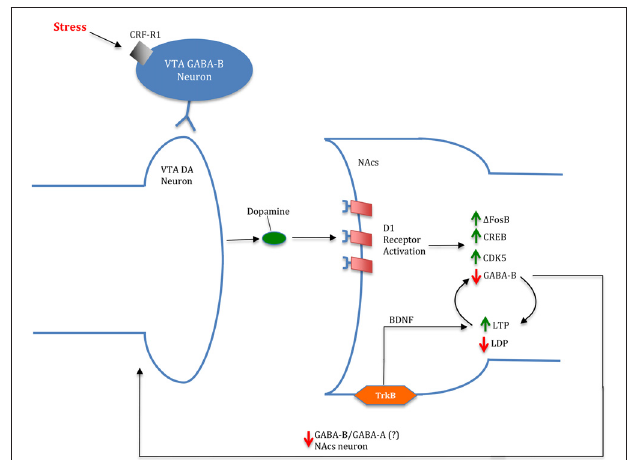
FIGURE 3 | Image of a potential mechanism for stress- and cocaine-induced drug dependence via a feed-forward cycle in the NAcs. In the presence of stress, ventral tegmental area (VTA) DA release is upregulated resulting in increased D1 receptor activation. Cortisol is implicated in increasing DA release through corticotropin-releasing factor acting at type 1 receptor (CRF-R1) binding to gamma-aminobutyric acid (GABA)-B VTA neurons acting on VTA DA neurons. Increased DA levels promote D1 activation leading to an increase in ∆ FosB, CREB and CDK5 levels in the NAcs. Moreover, D1 activation is linked to decreased GABA-B activation in the NAcs, resulting in greater long-term potentiation (LTP): long-term depression (LDP). Attenuation of GABA projections from NAcs to the VTA is suggested to further DA release; however, the particular projection (GABA-A/GABA-B) is currently unknown. Furthermore, brain-derived neurotrophic factor (BDNF) is implicated in contributing to LTP in the NAcs through activation of tropomyosin receptor kinase B (TrkB)